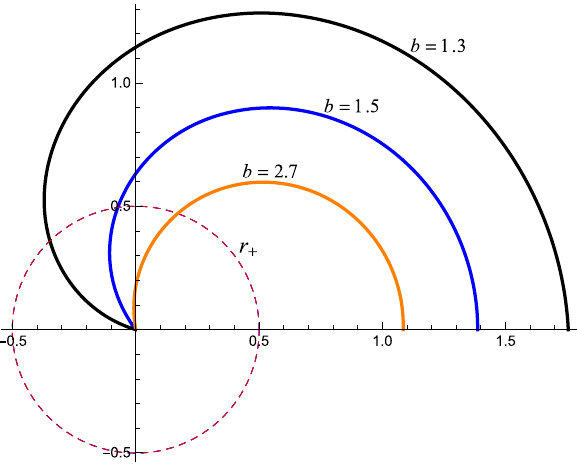
Fig. 8 Orbits of the second kind for particles approaching the black hole at r = r P , for three different impact parameters, b = 1 . 3 , 1 . 5 and 2 . 7. As we can see, smaller impact parameters in this kind of orbit result in larger paths for the orbiting particles before their fall into the event horizon, and therefore, a more intense change in the shape of orbit in the final segment. The plots have been done for Q = 1 and λ =